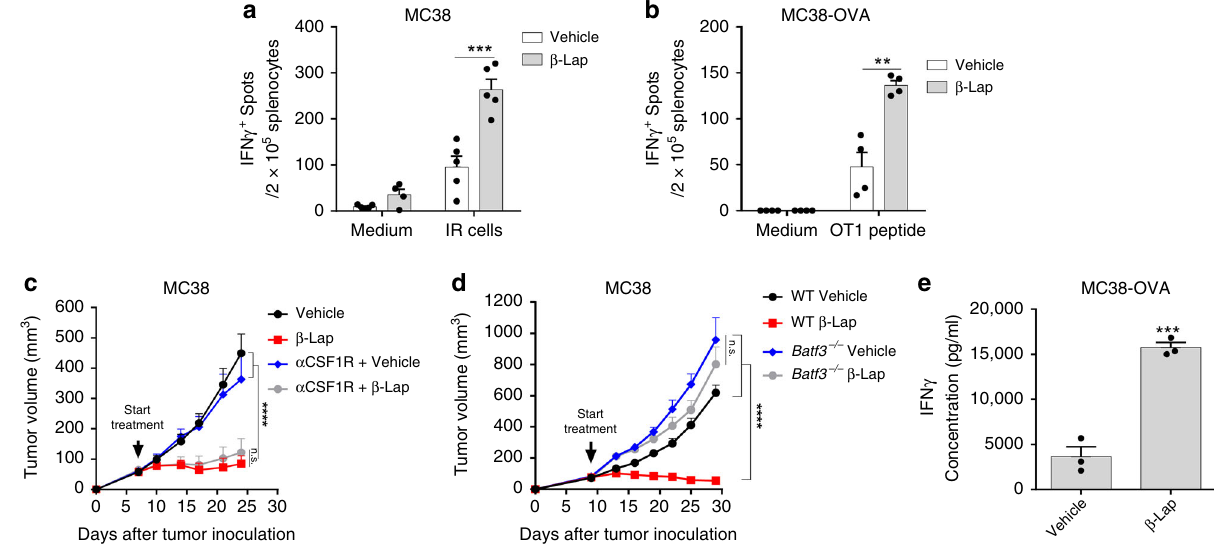
Fig. 3 β -Lap induces Batf3-dependent dendritic cell-mediated T cell cross-priming. a C57BL/6 mice ( n = 5/group) were transplanted with 6 × 10 5 MC38 cells and treated with β -lap (15 mg/kg, i.t.) every other day for three times, and 10 days after the fi rst treatment, lymphocytes from the spleens were isolated and stimulated with medium or MC38 cells irradiated with 60 Gy. b C57BL/6 mice ( n = 4/group) were transplanted with 1 × 10 6 MC38-OVA cells and treated with β -lap (15 mg/kg, i.t.) every other day for three times, and 10 days after the fi rst treatment, lymphocytes from the spleens were isolated and stimulated with 2.5 μ g/ml of OTI peptide. IFN γ -producing cells were determined by ELISPOT assay. c C57BL/6 mice ( n = 5/group) were transplanted with 6 × 10 5 MC38 cells and treated with β -lap (15 mg/kg, i.t.) every other day for four times. One hundred micrograms of anti-CSF1R Ab were intratumorally injected three times at three days interval during the treatment. d 6 × 10 5 MC38 cells were subcutaneously transplanted into C57BL/6 WT ( n = 5/group) and Batf3 − / − mice ( n = 5 for vehicle treatment group; n = 6 for β -lap treatment group), respectively. Tumor-bearing mice were treated with β -lap (15 mg/kg, i.t.) every other day for four times. Tumor growth was monitored twice a week. e MC38-OVA-bearing mice ( n = 3/group) were treated with β -lap (15 mg/kg, i.t.) for one dose, and 4 days later, CD11c + dendritic cells were puri fi ed from the tumor drain lymph nodes, and co-cultured with CD8 + T cells isolated from the spleen of OT-1 transgenic mice. The activity of cross-priming of T cells was determined by the level of cell-secreted IFN γ via Cytometric Bead Array (CBA) mouse IFN γ assay. Data are shown as mean ± SEM from three independent experiments. ** p < 0.01, *** p <